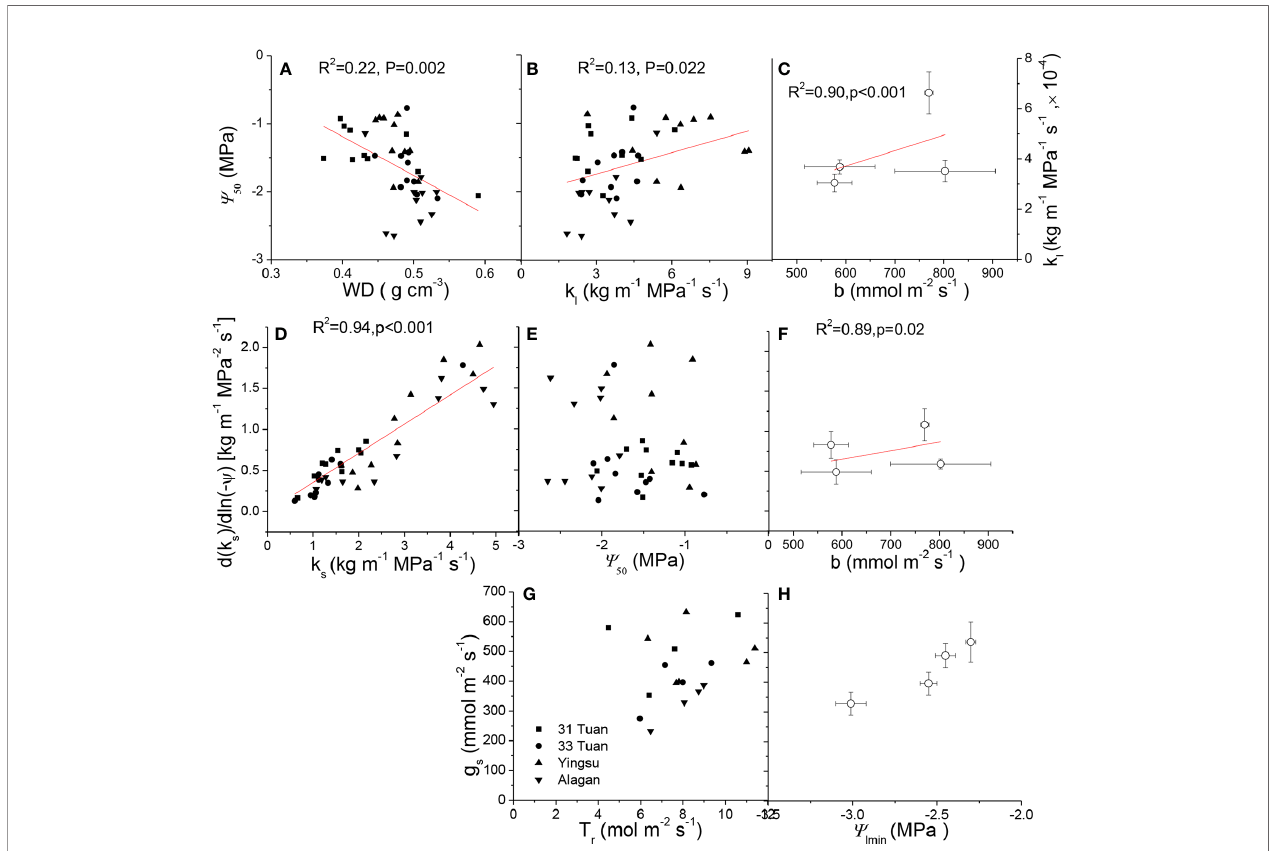
FIGURE 4 | Y 50 as a function of: (A) WD and (B) k l. k l as a function of b at the population scale (C) . d( k s )/dln( − Y ) as a function of: (D) k s , (E) Y 50 , and (F) b at the population scale of Populus euphratica at the four sites. g s as a function of: (G) T r , and (H) Y min at the population scale of Populus euphratica at the four sites. In Figures 4C, F and H , data were shown as mean ± 1 se. For relationships at the population scale, the four points are the means of the four